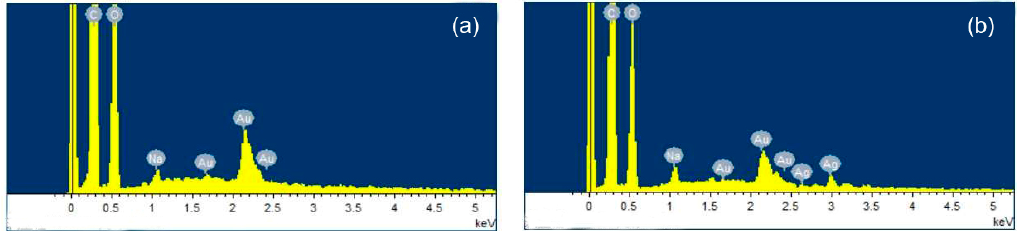
Figure 5. Energy-dispersive X-ray spectra FK/PVA/PEO composite nanofibers: ( a ) 0%-AgNPs, ( b ) 3%-AgNPs.